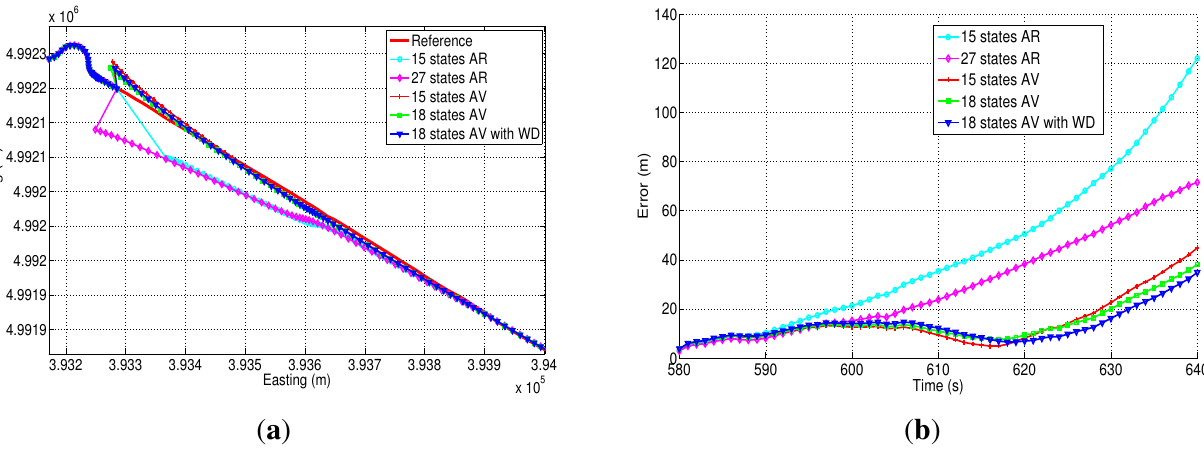
Table 9. Maximum and mean horizontal position error during GPS outages for trajectory